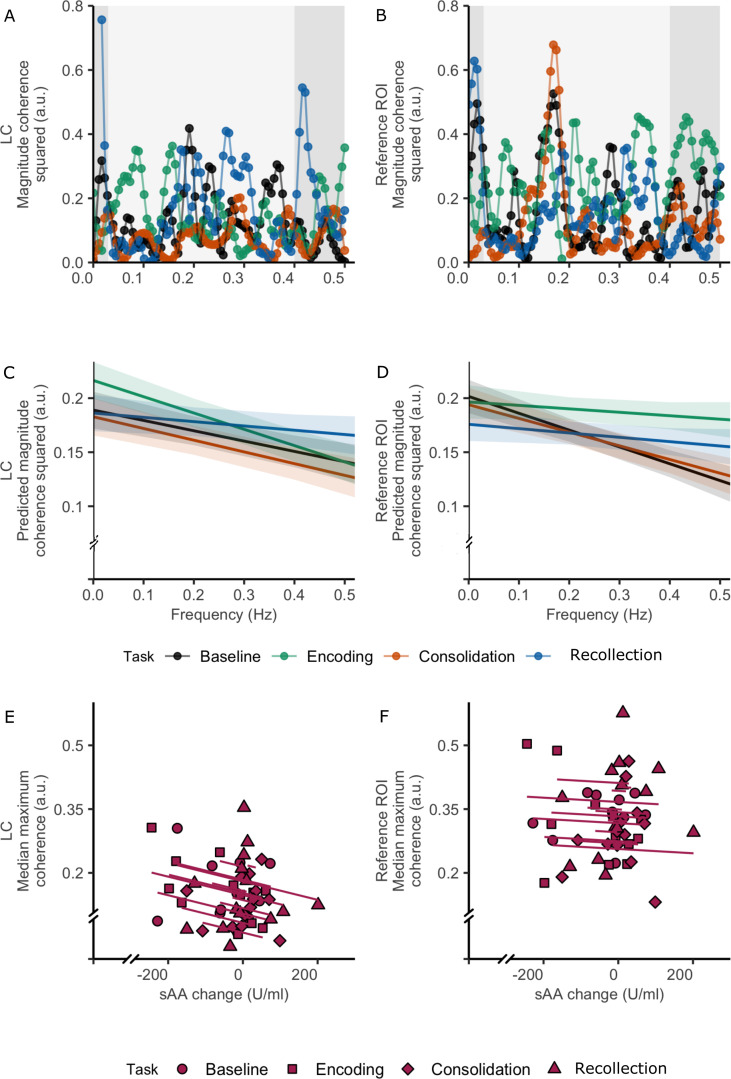
Coherence between LC and HRV across the task stages for the spatially normalized pipeline.Note: Coherence between LC and HRV across the task stages. (A) LC coherence magnitude squared plotted against frequency for each task stage for a single participant. The high-frequency HRV band is depicted in a lighter shade. (B) Reference ROI-HRV coherence magnitude squared for the same participant. (C) The association between frequency and the predicted magnitude squared coherence between the LC and HRV across the various task stages (based on linear mixed effects models,, N = 24 (7920 observations), p-values for all comparisons are provided in Supplementary file 4). Shaded regions in C and D show the 95% confidence intervals. (E) Repeated correlations between LC-HRV coherence and ΔsAA (Rrm(df)=−0.36 (34), p-value=0.031, CI (95%) = [−0.62,–0.03], N = 17, 56 observations). (F) Reference ROI-HRV coherence and sAA change levels (not significant, Rrm(df)=−0.05 (34), p-value=0.773, CI (95%) = [−0.38,–0.29], N = 17, 56 observations).